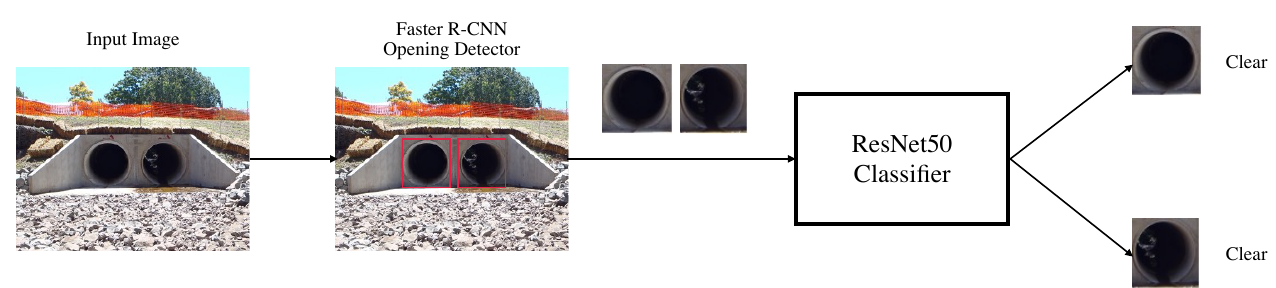
Figure 13. Conceptual block diagram of detection-classification pipeline for visual blockage